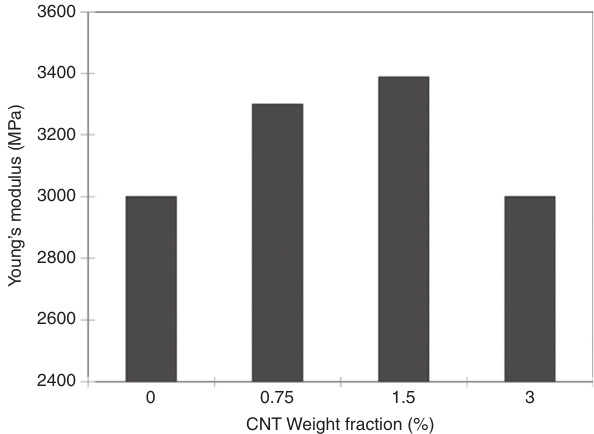
Figure 5 Young’s modulus of CNT/epoxy nanocomposites in various CNT weight